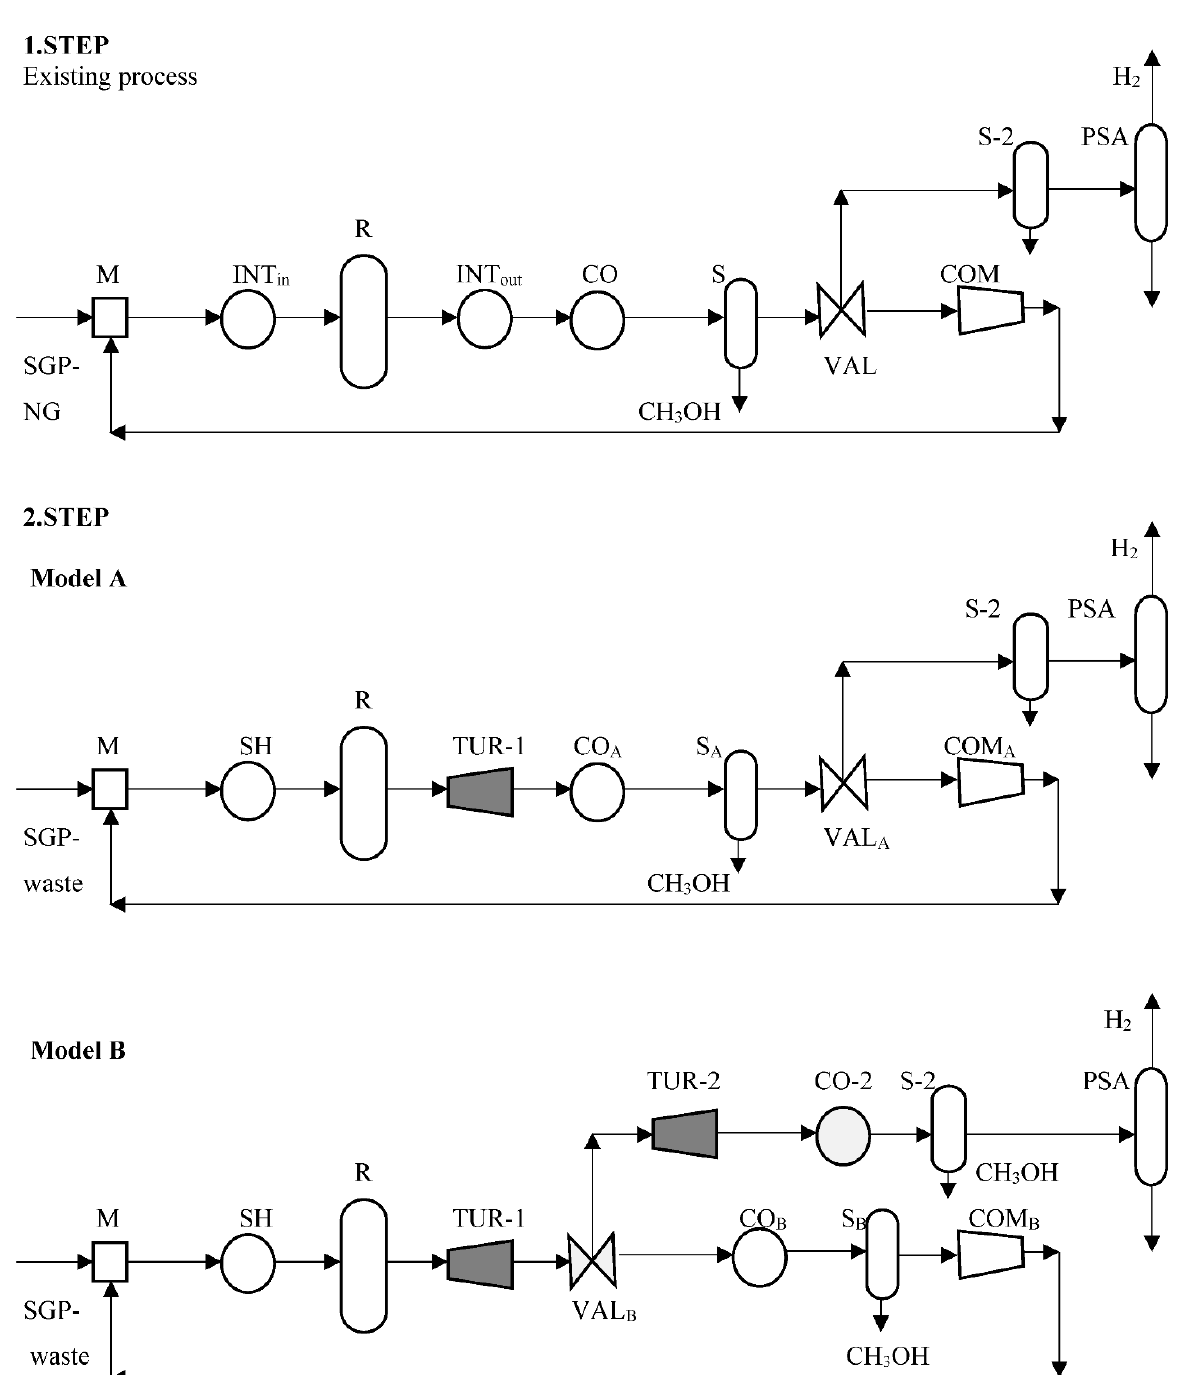
Figure 1. Flow diagram of the upgraded electricity cogeneration technique. The maximum available electricity cogeneration ( P el-TUR ; Equations (1) and (2)) was previously determined from the product thermodynamic using the heat capacity of the outlet flow rate ( FCp TUR ), the number of components going into the outlet ( FCp TUR,com ; com = 1 . . . Com), and the temperature difference between the inlet ( T TUR,in ) and outlet ( T TUR,out ) gas turbines ( ∆ T TUR ). The turbine’s power ( P TUR ; with η tur ) and heat flow rate ( ϕ TUR ; with η tur ) is calculated by using Equation (2). The total thermodynamic and mechanical effi- ciency of both medium-pressure turbines ( η tur ) is 70%, and the same for electricity cogen- eration ( η el ).